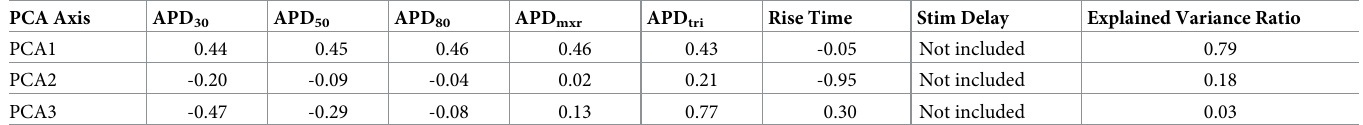
Table 2. Principal component analysis of specific ion channel block in computer modeling. PCA1 is a major axis that underlies overall APD prolongation and explains 79% of the variance in the simulation data. PCA2 mainly detects changes in the rise time of the AP upstroke with a smaller contribution due to shortening of APD 30 and prolongation of APD triangulation. In computer simulation, the delay between stimulation and AP upstroke was small compared to the sampling rate and the stimulation delay parameter was not incorporated in calculating PCA